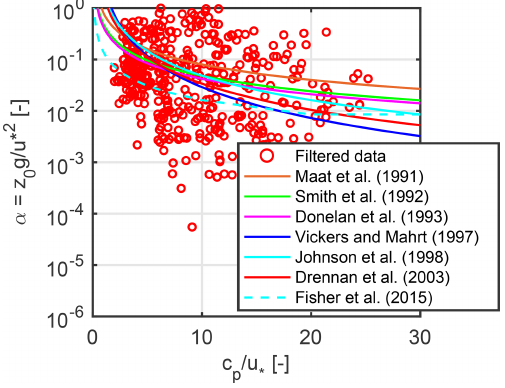
Figure 5. Charnock-coefficient ( α ) as a function of wave age. Figure 6.